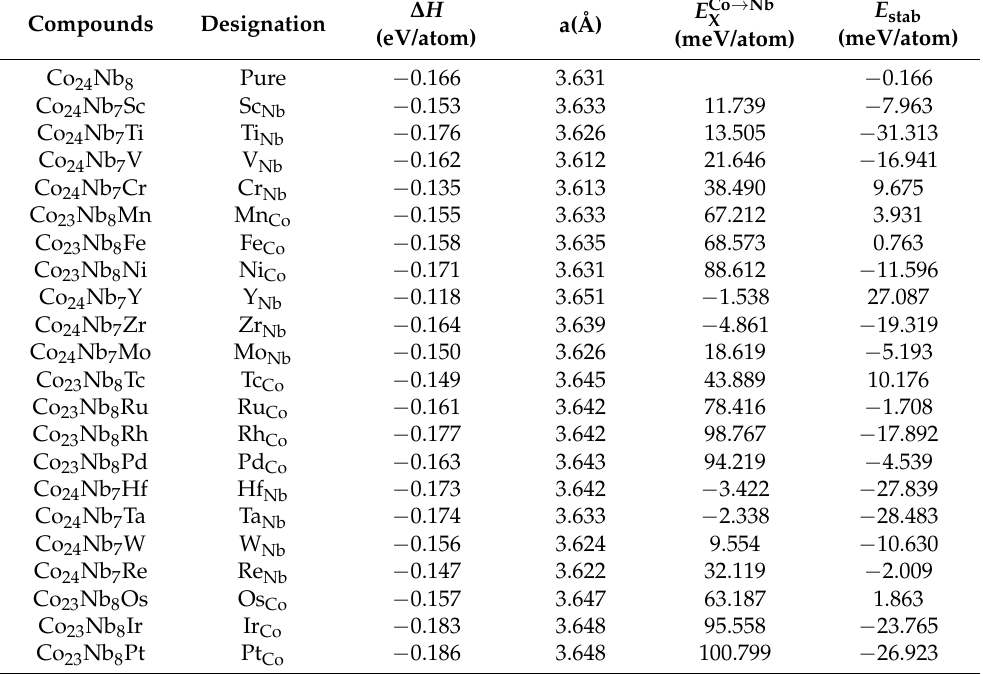
) X → Co Nb E ) and stable formation en- X